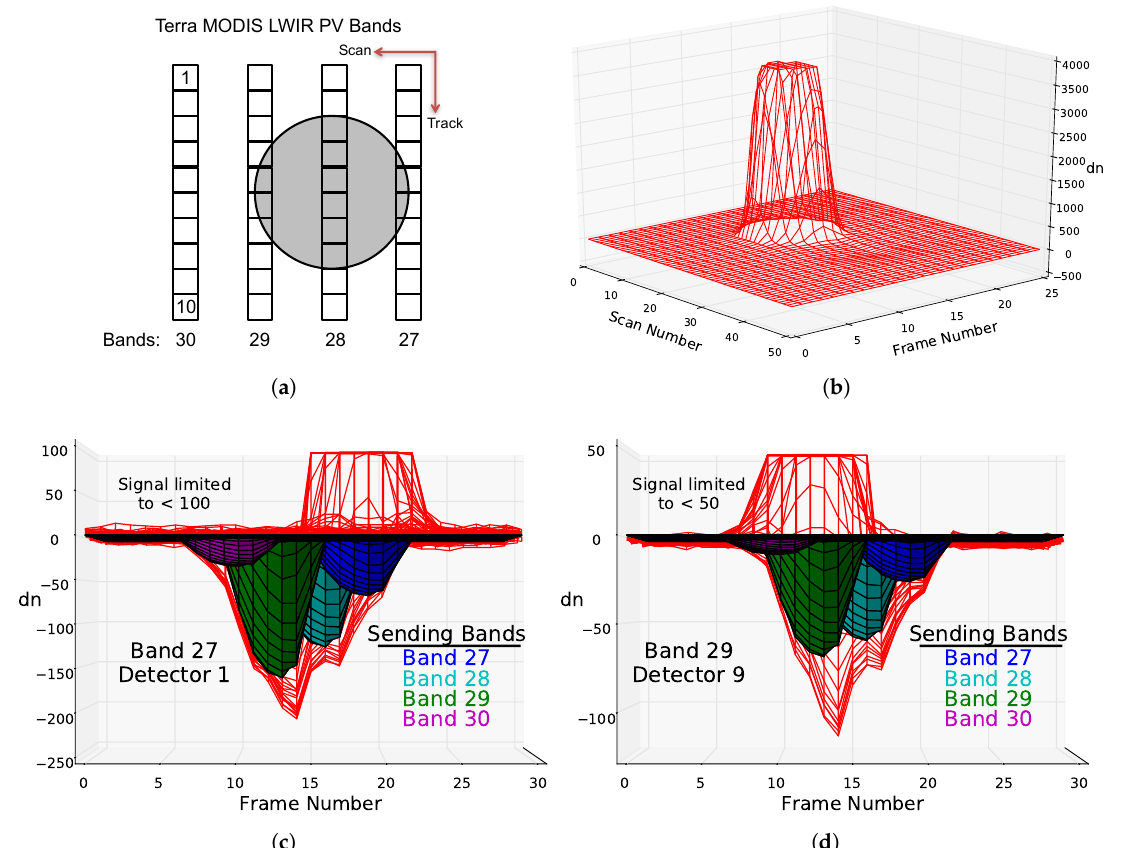
Figure 2. Example signals from lunar images from the LWIR PV bands. In ( a ), we show the layout of the LWIR PV bands on the FPA, with a circle superimposed representing the relative size of the lunar image on the FPA. The detectors are labeled in product order. In ( b ), we plot the background-subtracted signal versus scan and frame number for a single detector (Band 29, Detector 9). The peak of the signal saturates when viewing the moon because of the high brightness temperature relative to the usual Earth-view scene data. In ( c , d ), we show the lunar signal limited to low signal levels, where the negative signal is due to crosstalk contamination. On these plots, we also show the alignment of the sending band signals, which are derived from the measured lunar signal of the sending bands. The sending signals are shown after a saturation correction has been applied, and are scaled to